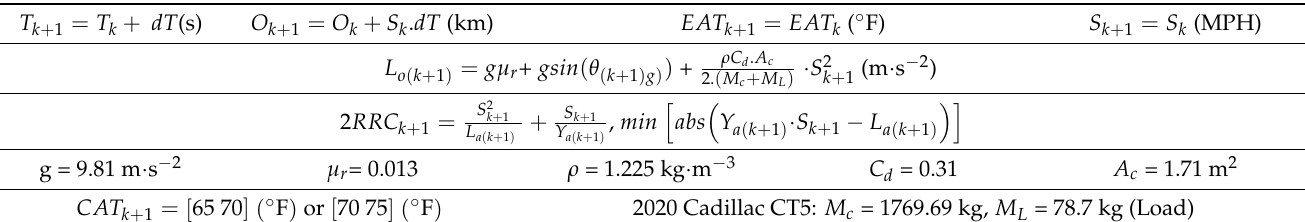
Table 1. Equation Set—Prediction of future input states.